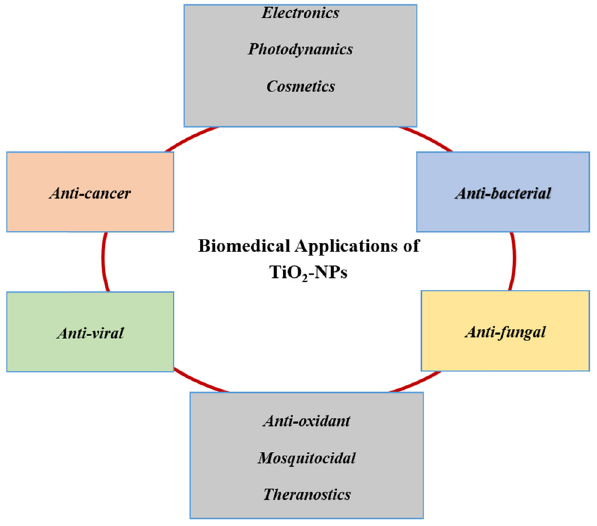
Figure 4: Biomedical and other applications of TiO 2 - NPs.